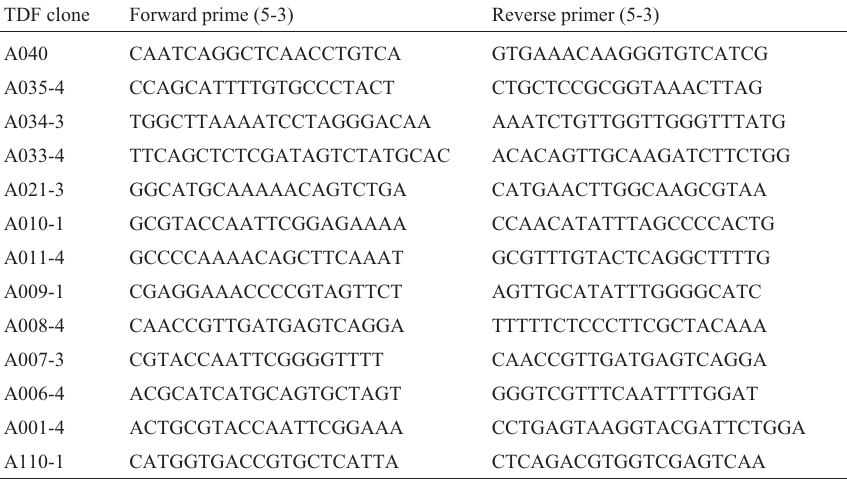
Table 2 - Sequences of the primers used for